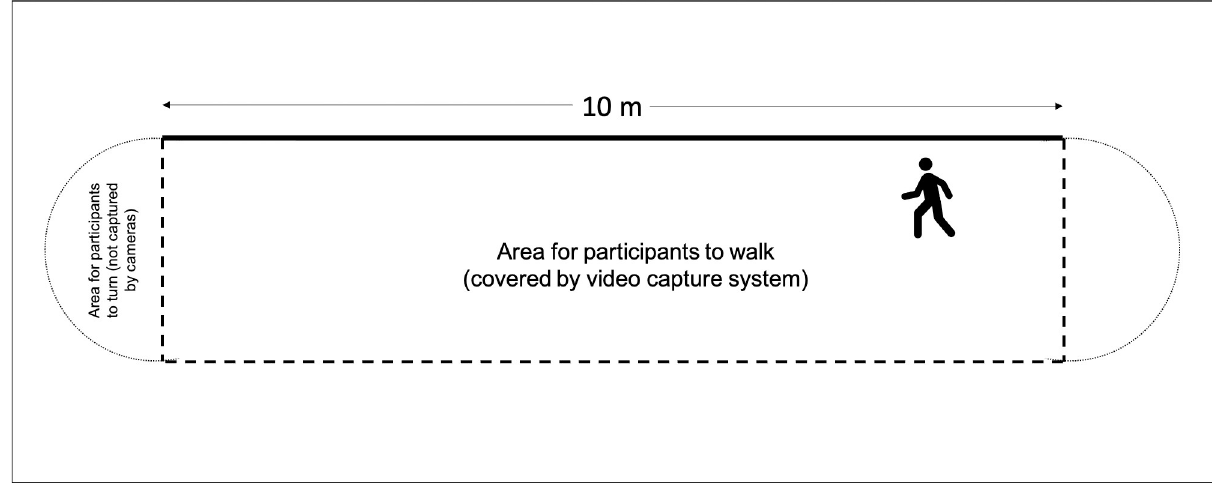
Fig 2. Schematic diagram of walking